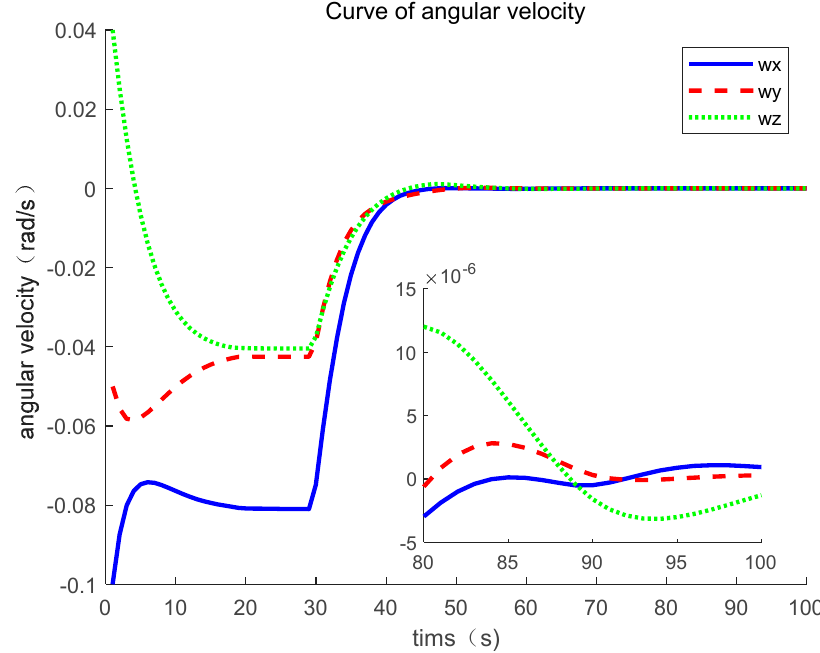
Figure 5. Curve of angular velocity under the controller proposed in this paper.